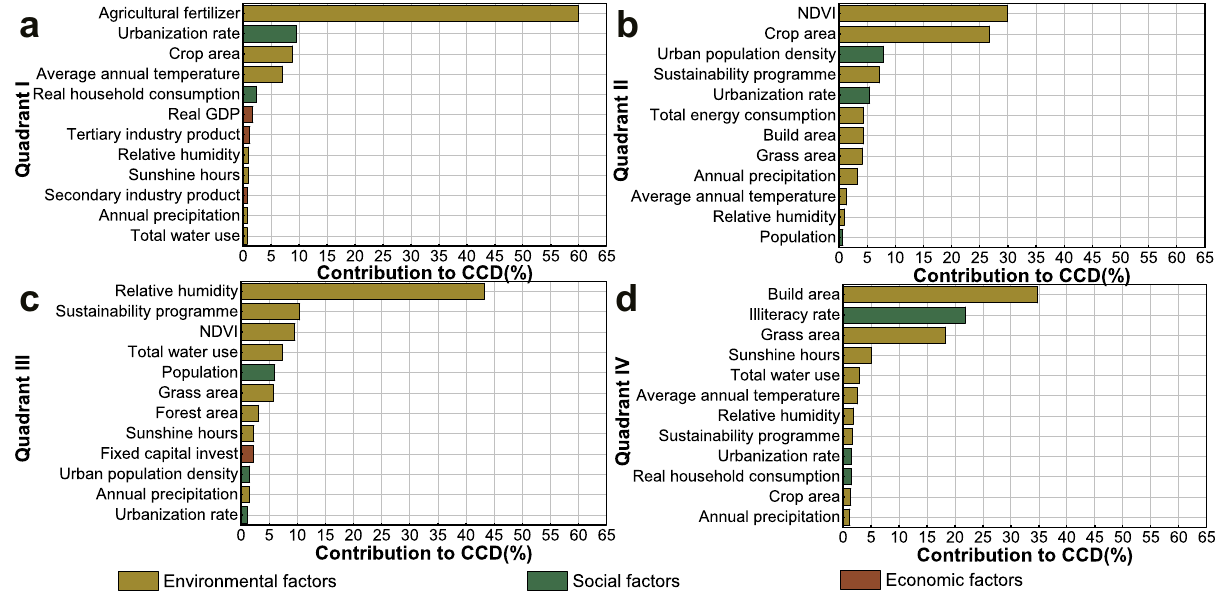
Fig. 8 | Contribution of drivers to variations of coupling coordination degree between environmental performance and human well-being. a Quadrant I. b QuadrantII. c QuadrantIII. d QuadrantIV.Shownaretherelativecontributions,as integerpercentage(%).Foreachindicator,weshowthecontributionofeachofthe